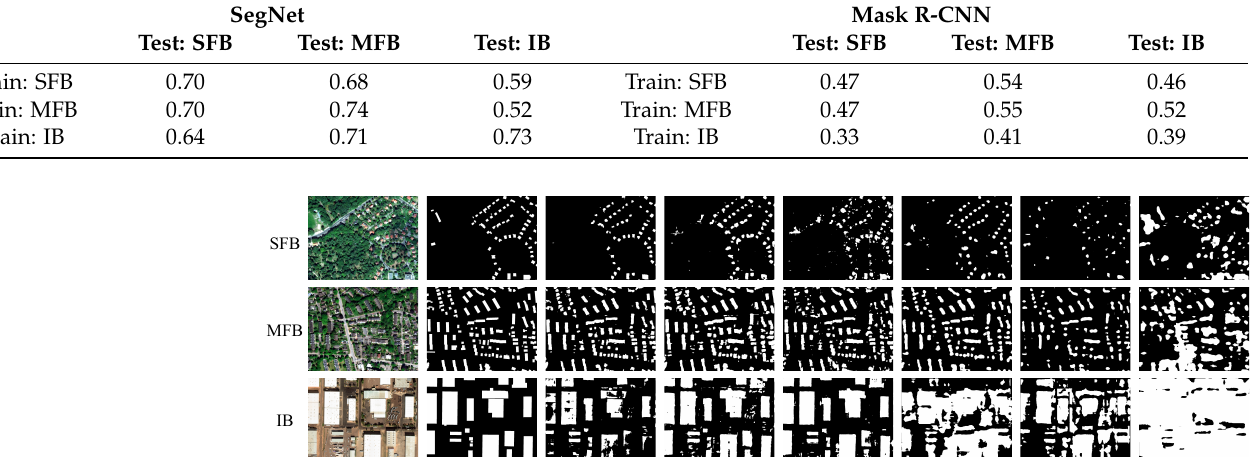
Table 7. Robustness to different building structures (RQ5). Test DICE scores of SegNet and Mask R-CNN trained on single family buildings (SFB), multiple family buildings (MFB), and industrial buildings (IB), respectively.